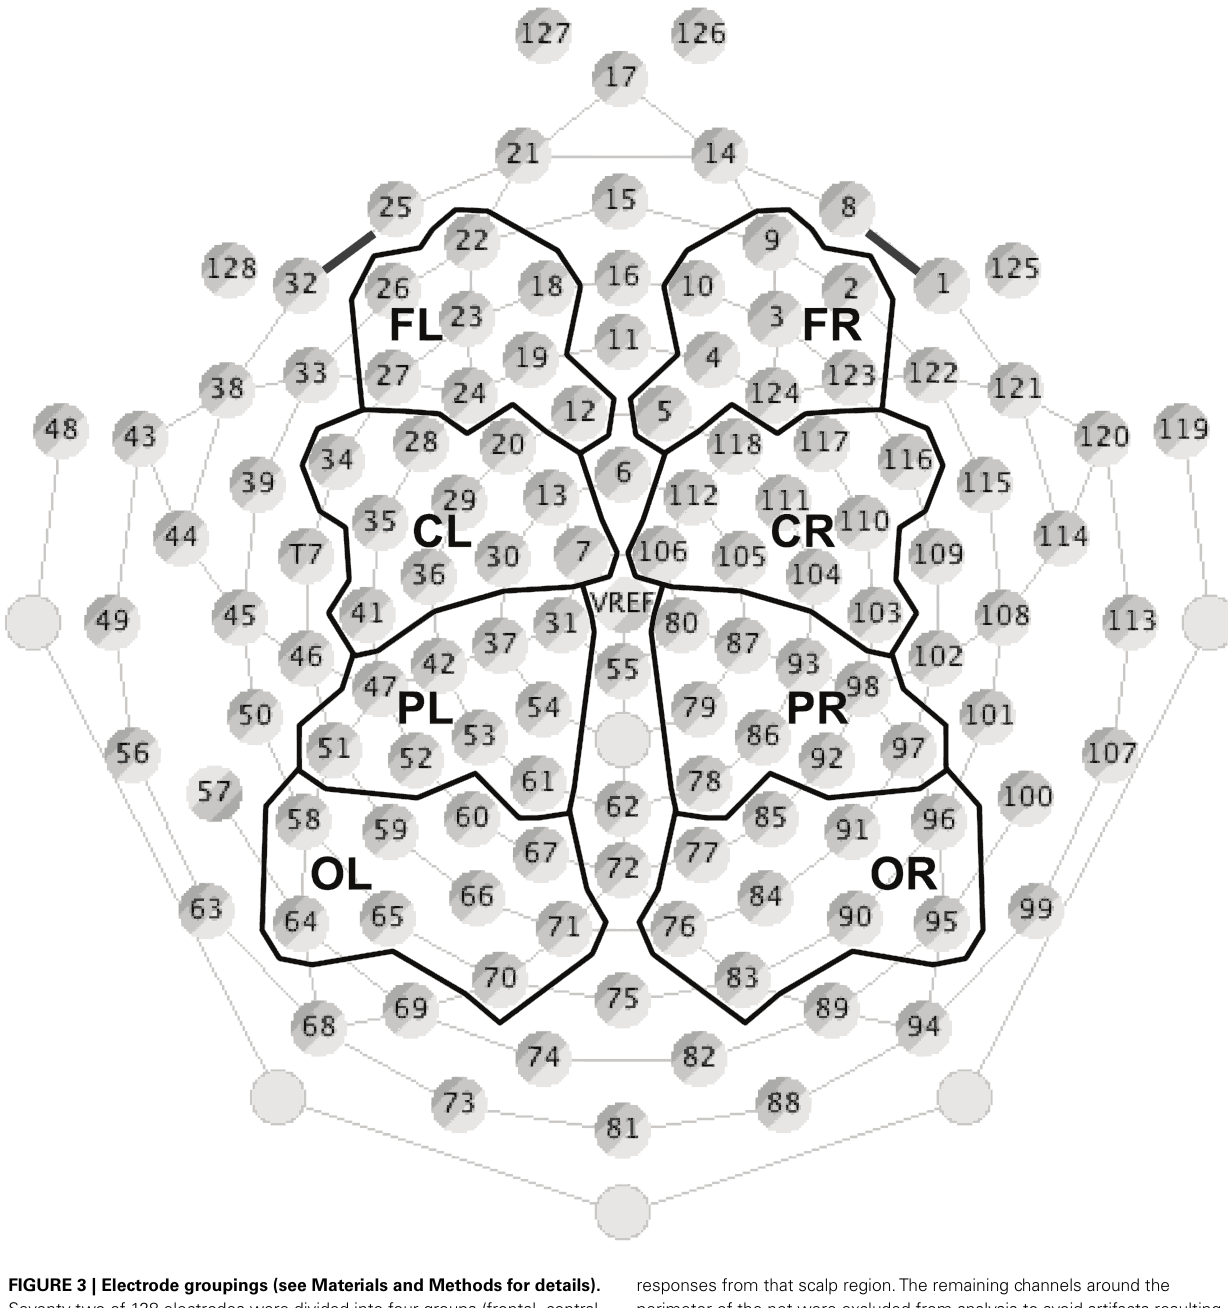
responses from that scalp region.The remaining channels around the perimeter of the net were excluded from analysis to avoid artifacts resulting from muscle activity in the face and neck, and channels along the midline were removed to allow for comparison between